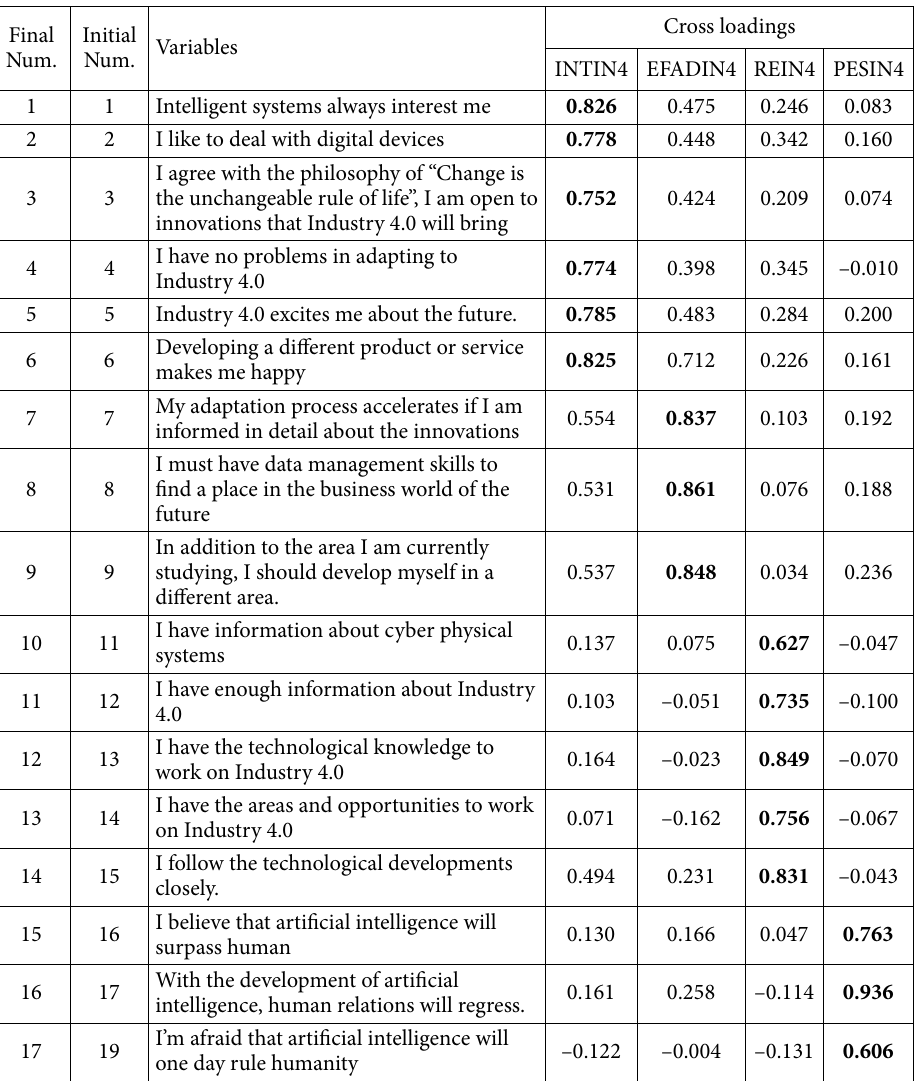
Table 9. Cross-loading